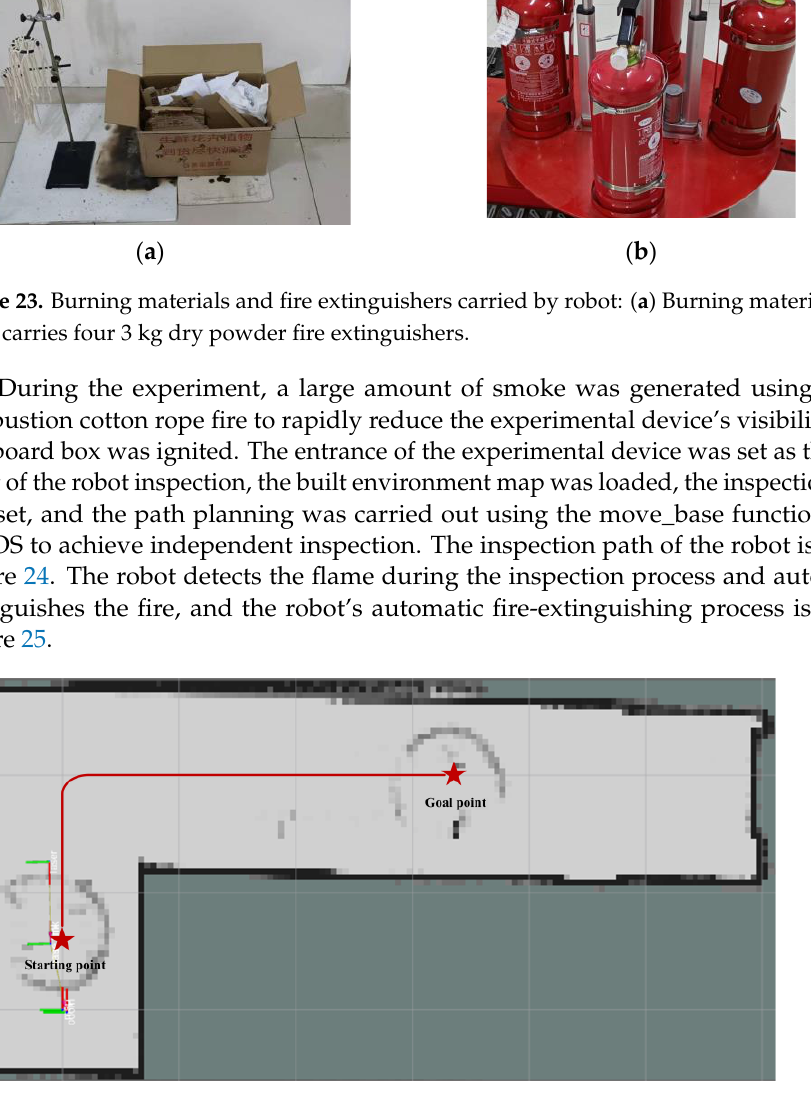
Figure 24. Inspection path of the robot.